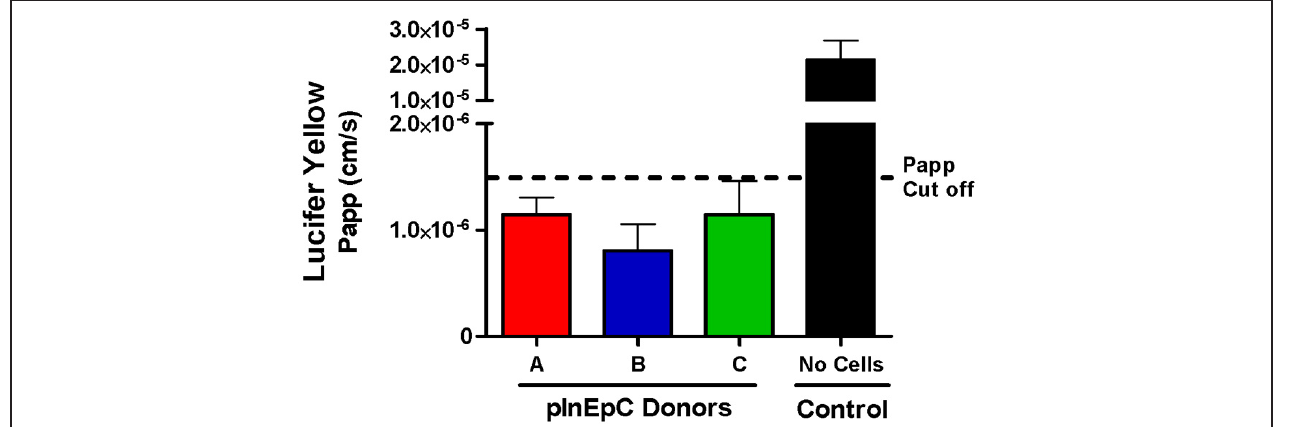
FIGURE A3 | All primary hInEpC donors used within the P-glycoprotein transport assay showed an average lucifer yellow apparent permeability (Papp) below accepted cutoff for intact monolayers